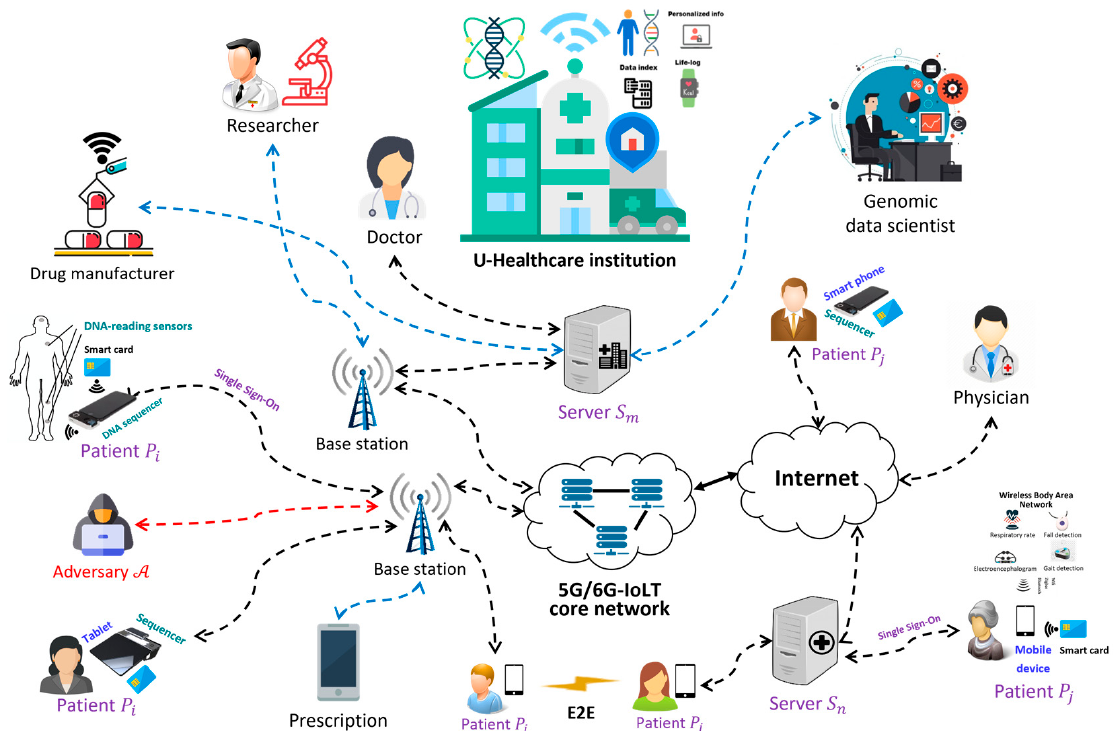
Figure 1. System model of the proposed protocol.